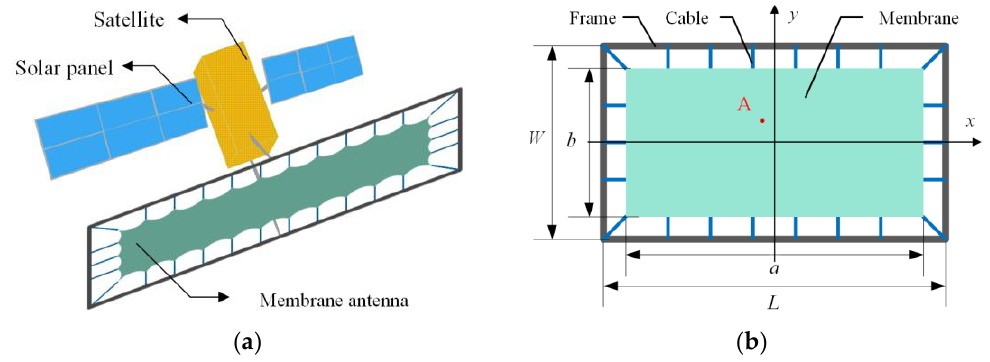
Figure 1. Schematic diagram of the in-orbit satellite with a membrane antenna. ( a ) The satellite and its membrane antenna ( b ) Schematic diagram of the membrane antenna.